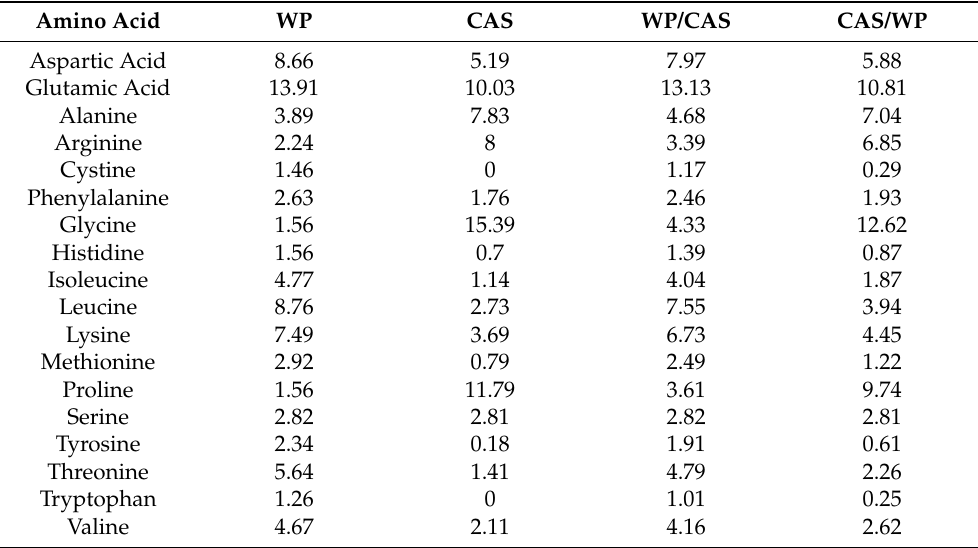
Table 1. Amino acid composition in 100 g of each protein supplement (g/100